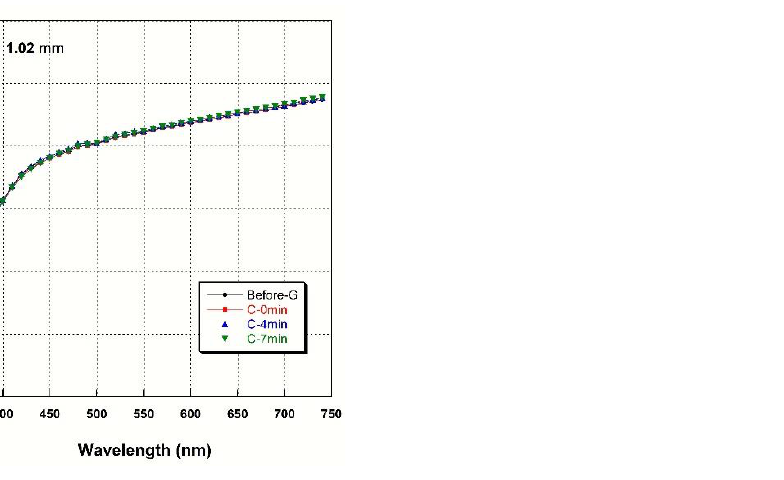
Figure 3. Spectral transmittance curves for various cooling rates at a thickness of 1.02 mm.